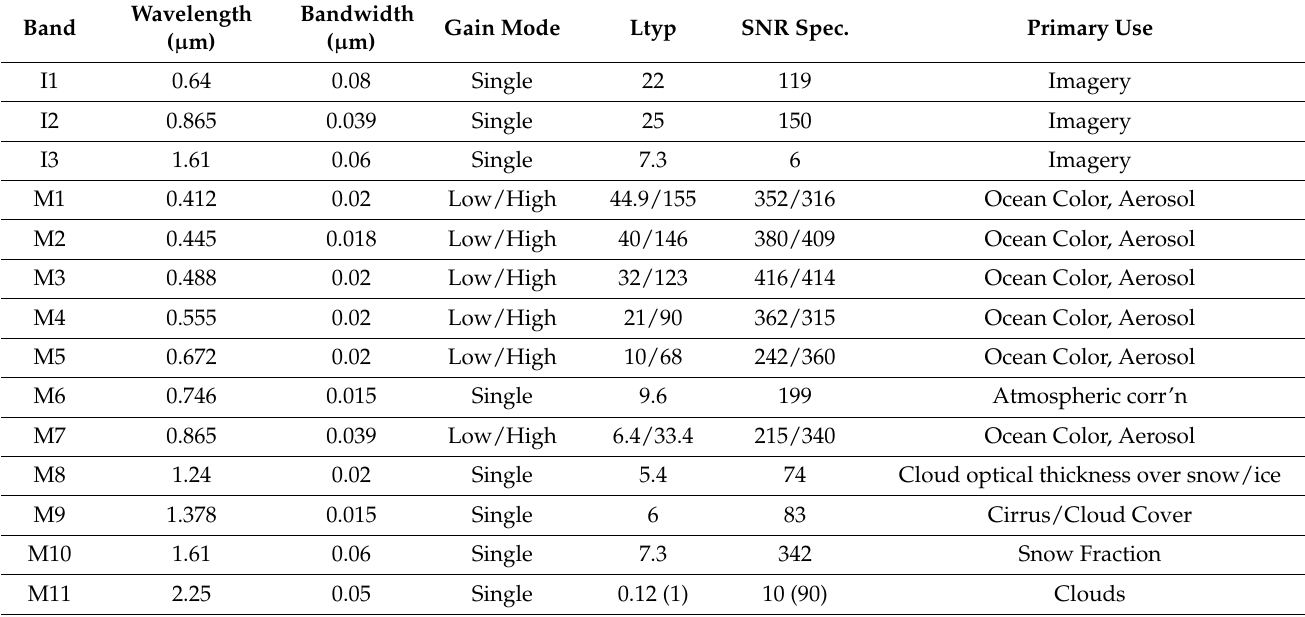
Table 1. A summary of spectral characteristics (in µ m), typical radiance (in W/m 2 / µ m/Sr), signal to noise ratio (SNR) and noise equivalent temperature difference (NEdT; in K), and the primary purposes of each SNPP VIIRS band. The SNR are based on pre-launch measurements and three on-orbit time periods. The NOAA20 band M11 values are shown in